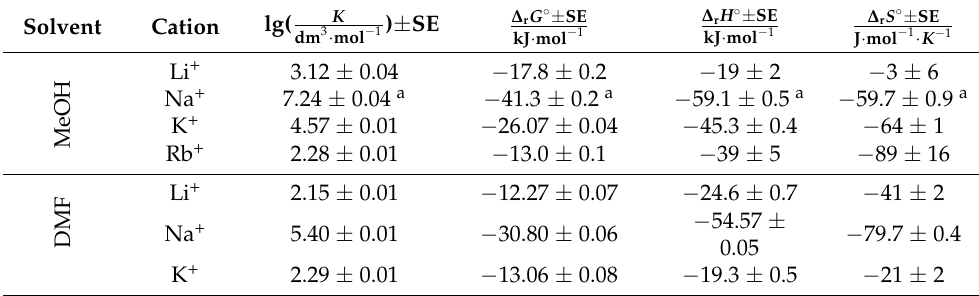
Table 2. Thermodynamic parameters for complexation of alkali metal cations with compound l in examined solvents at 25 ◦